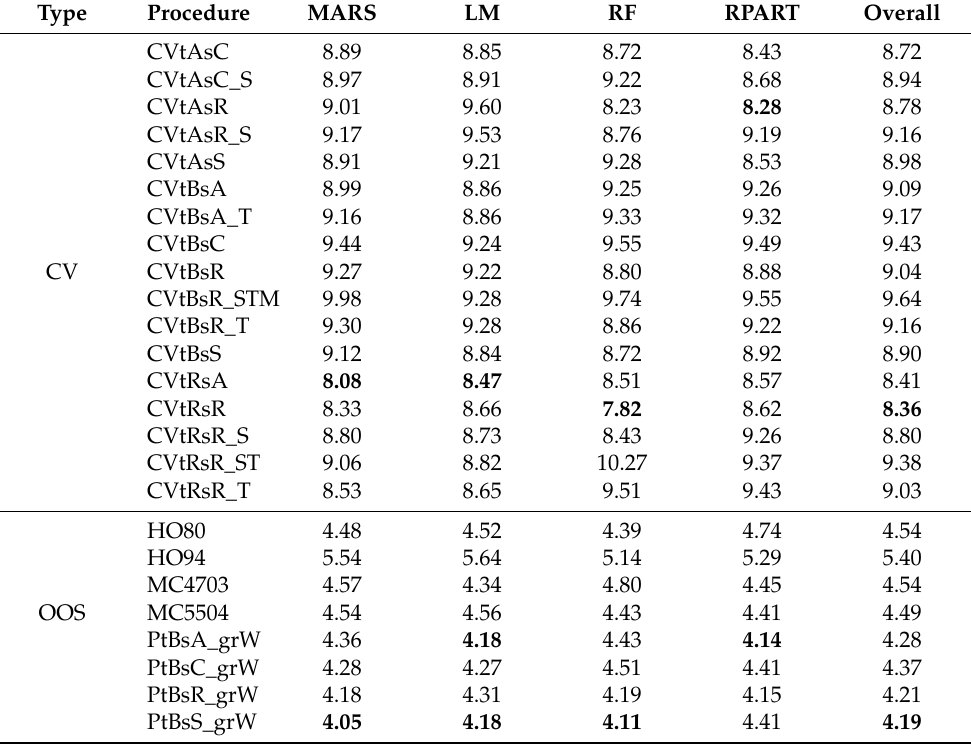
Table 4. Average ranks of absolute errors, calculated separately for cross-validation and out-of- sample procedures when estimating performance on 192 artificial datasets. The best results are in